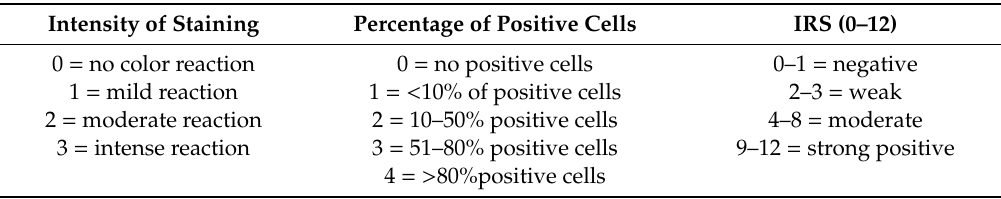
Table 3. IRS classification scoring